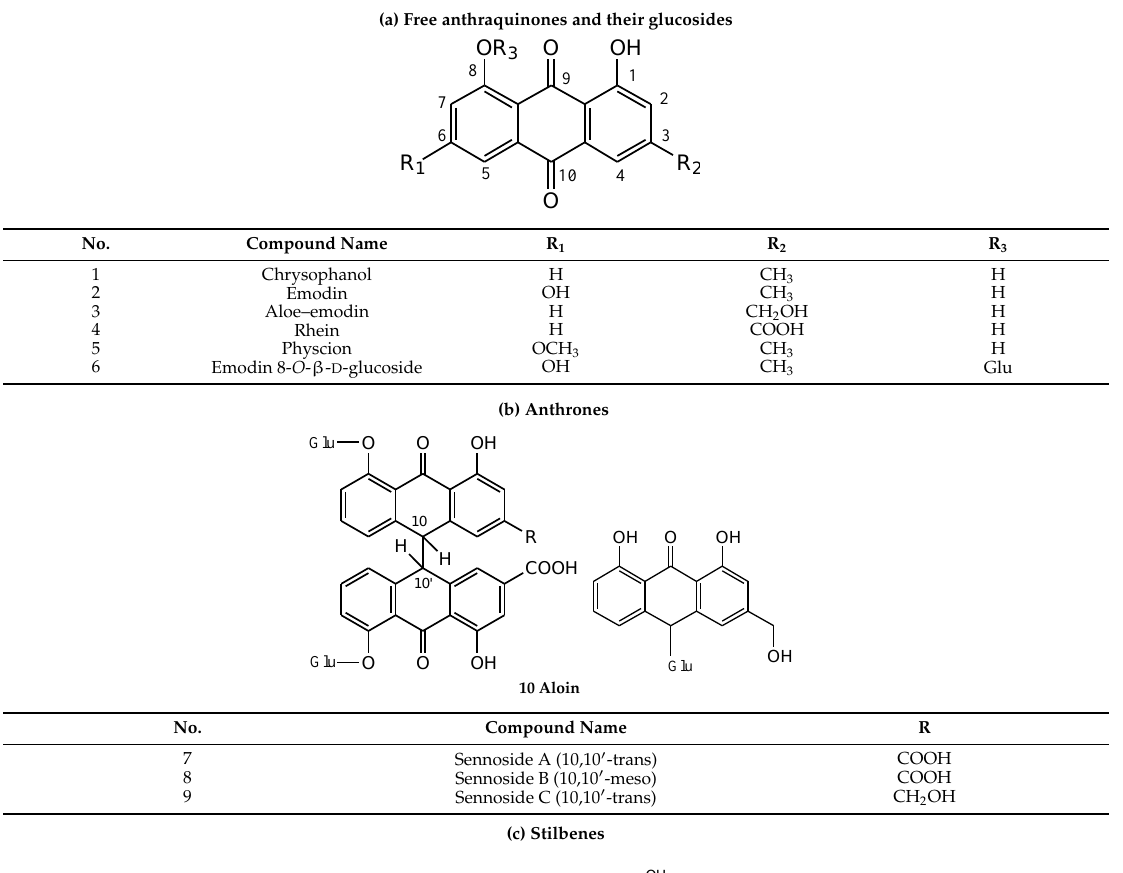
Table 2. Chemical structures of the twenty standard references.